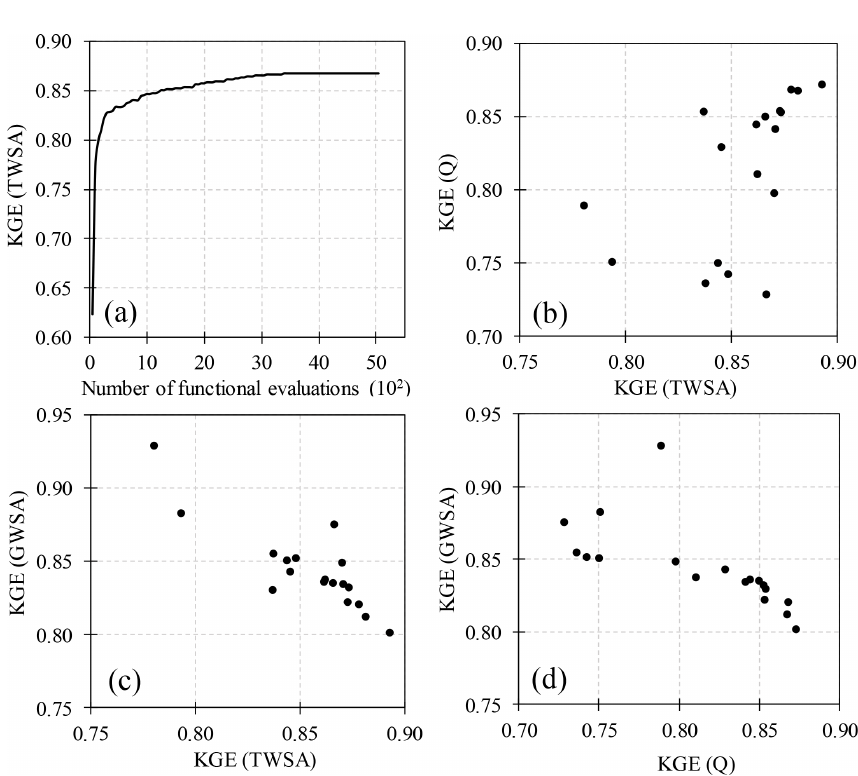
Figure 5. Best convergence history of GA in calibrating WGHM for the variant RS (a) and Pareto fronts for the multi-objective calibrations generated by NSGA-II for the variant RS_Q_GW_NA (b–d)